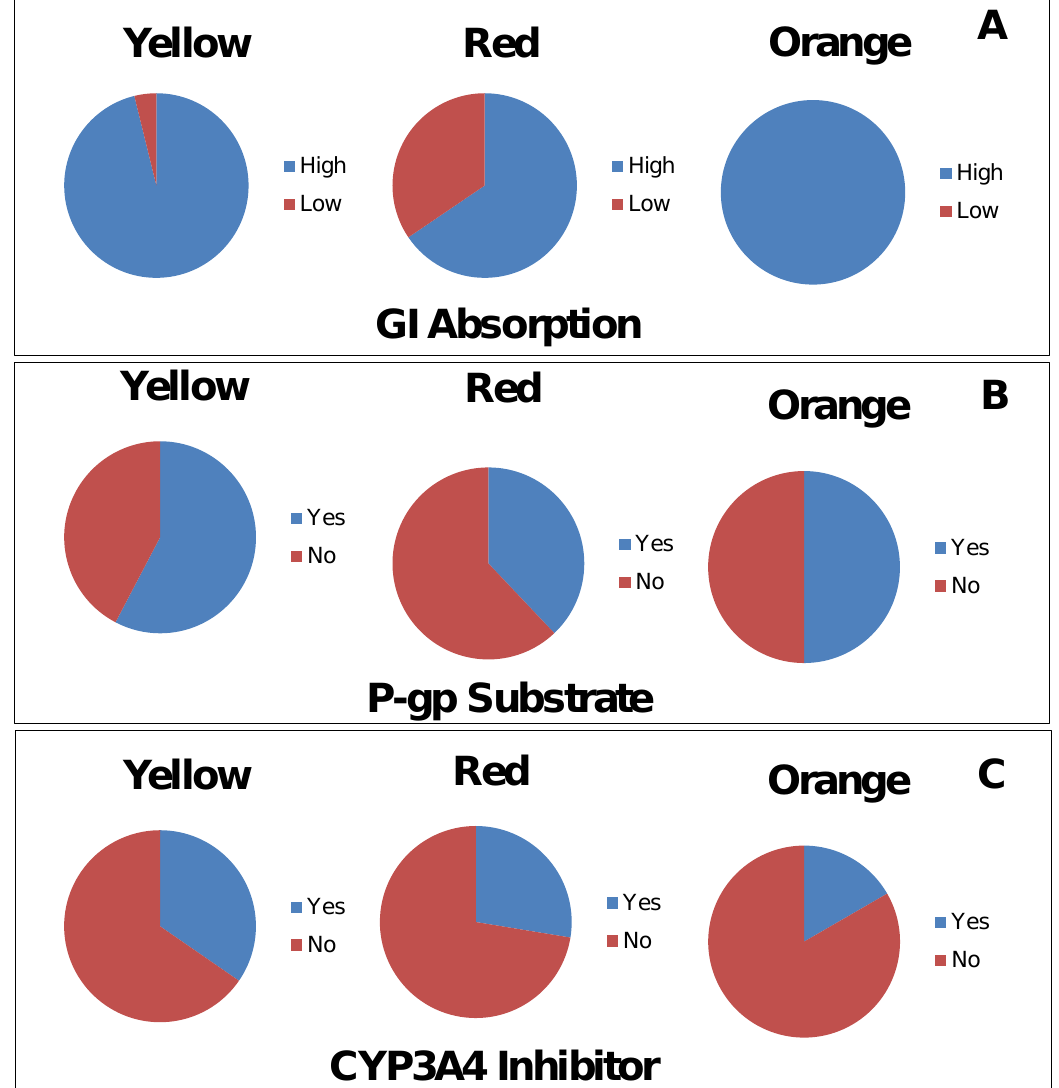
Figure 2. Distribution of pharmacokinetics (GI absorption ( A ), P-glycoprotein substrate ( B ), and CYP3A4 inhibitor ( C )) of the Monascus pigments.